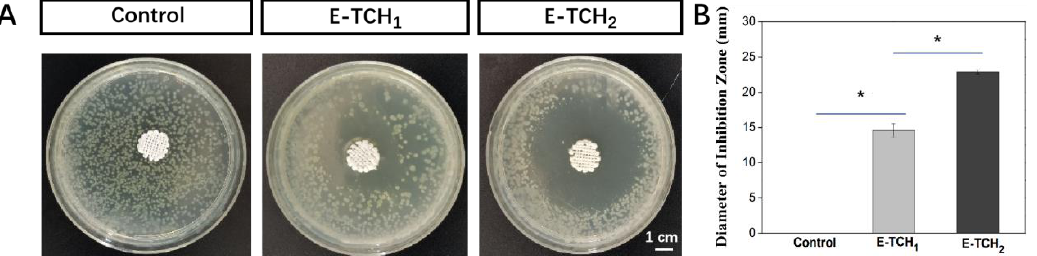
Figure 6. Antibacterial properties of porous scaffolds: ( A , B ) inhibition zone induced by different scaffolds after 24-h culture; ( B ) average diameter of the inhibition zone. * p < 0.05.